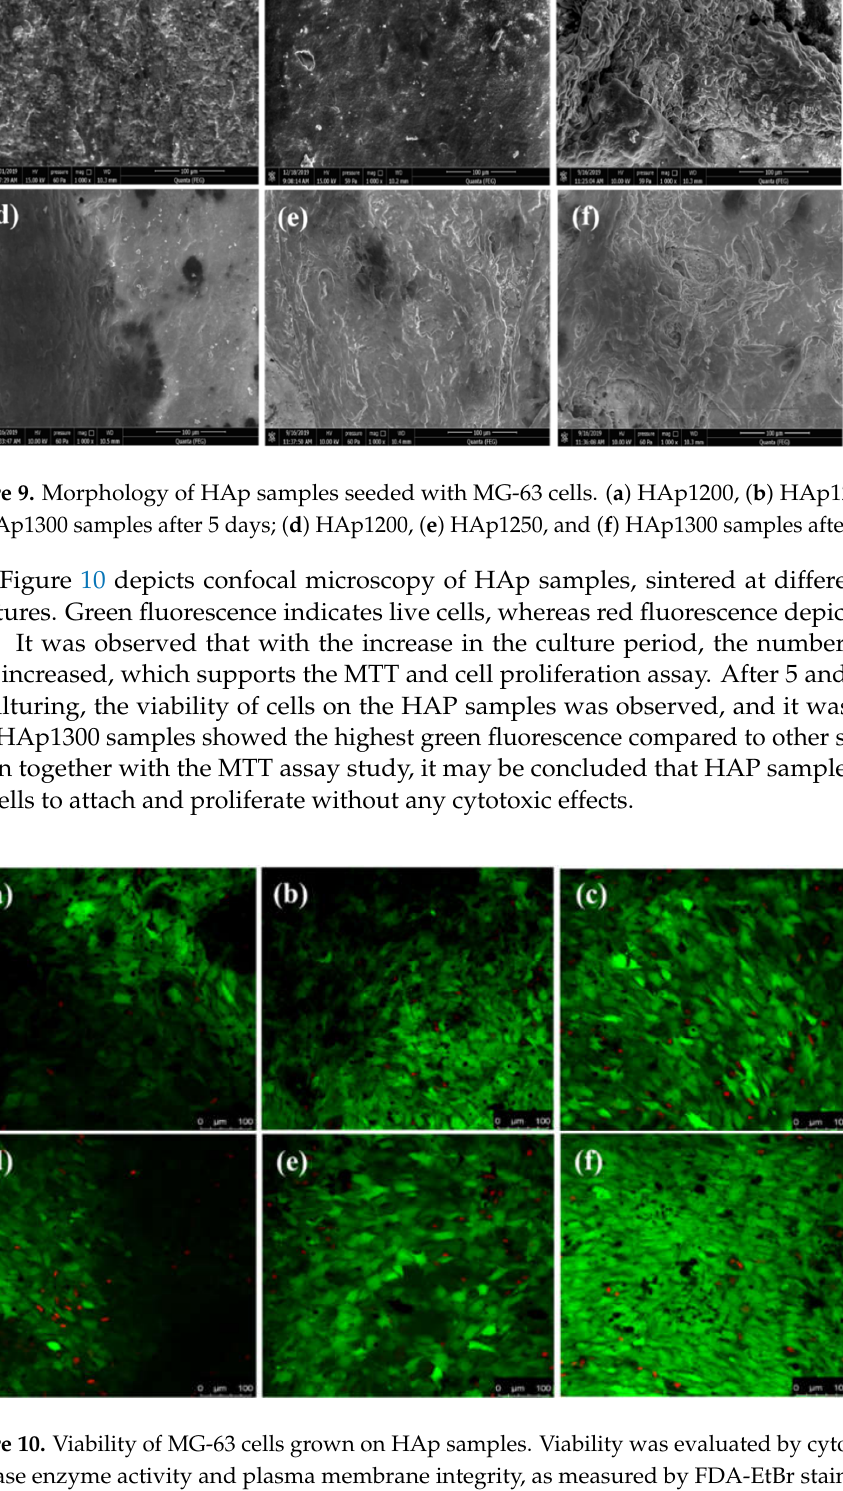
10 of 13 Figure 8. MTT assay of MG-63 cells cultured on HAp samples (sintered at different temperatures) for 7 days. * and ** correspond to significant differences at p < 0.05 and p < 0.01, respectively. Figure 9 shows a morphological study, analyzed by E-SEM, of MG 63 cells grown on sintered HAp samples for 5 and 7 days. Cell proliferation increased day by day, and a uniform formation of an apatite layer on the HAp samples’ surface was observed after 7 days. Multi-layer apatite formation was observed on the surface of HAp1300, whereas